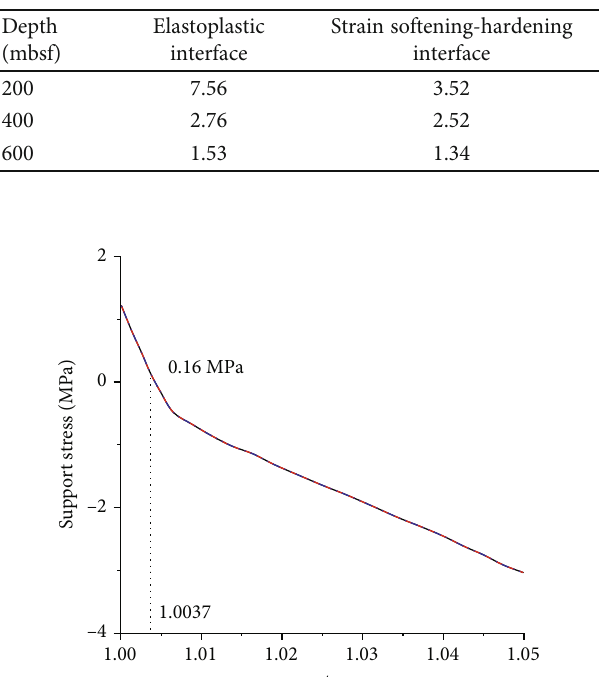
Figure 10: Relationship between borehole support stress and a under di ff erent hydrate